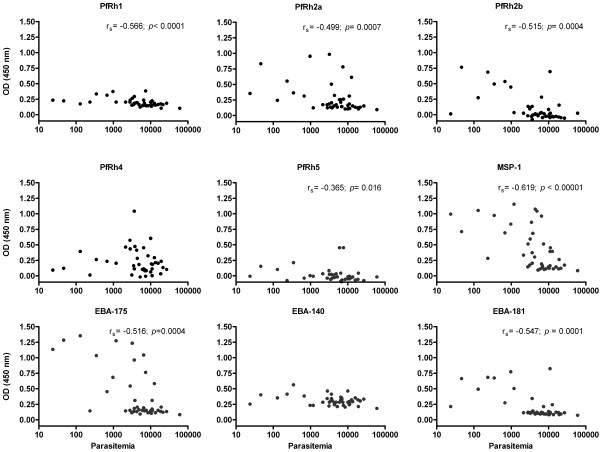
Total IgG response to EBL and PfRh ligands in Symptomatic and Asymptomatic malaria infected Peruvian individuals in relationship with their parasitaemia. The parasitaemia was determined by light microscopy and expressed as parasites/μL. Spearman correlation coefficient, abbreviated rs, and p value are shown.